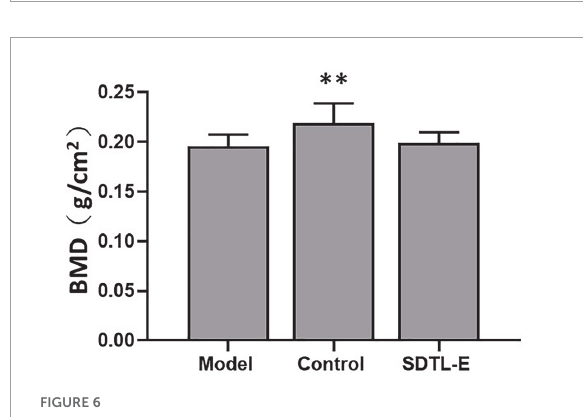
FIGURE5 SDTL-E treatment had no significant effects on urinary calcium/creatinine ratio of OVX-induced osteoporosis rats. Model Group ( n = 12) and Control Group ( n = 11) rats were treated with vegetable oil. SDTL-E Group ( n = 10) rats were treated with SDTL-E. All treatments were topically applied twice daily for 20 days. Urinary calcium/creatinine ratio was calculated by results obtained from calcium assay and creatinine assay. Values are mean ± SD .